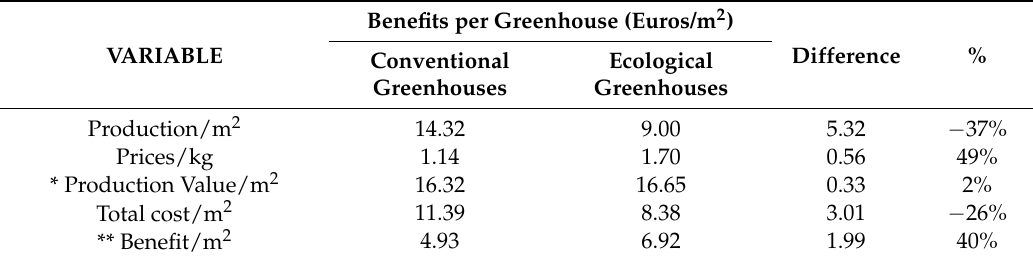
Table 5. Benefits in greenhouses 2002–2015. Source: fieldwork; * PV/m 2 = (Production/m 2 )(Prices/kg); ** Benefit/m 2 = PV/m 2 − TC/m 2